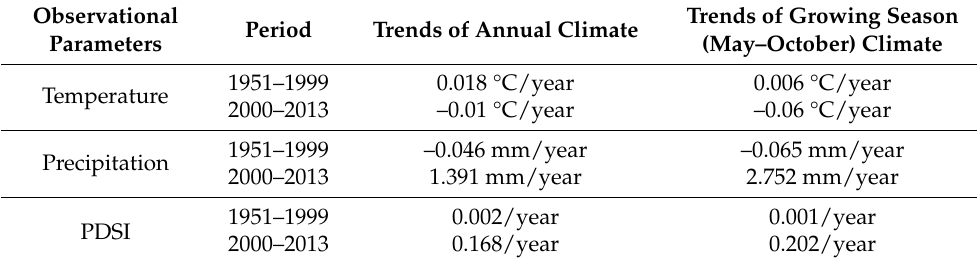
Table 2. Trends in temperature, precipitation and Palmer Drought Severity Index (PDSI) in the CW–DHM region during the periods 1951–1999 CE and 2000–2013